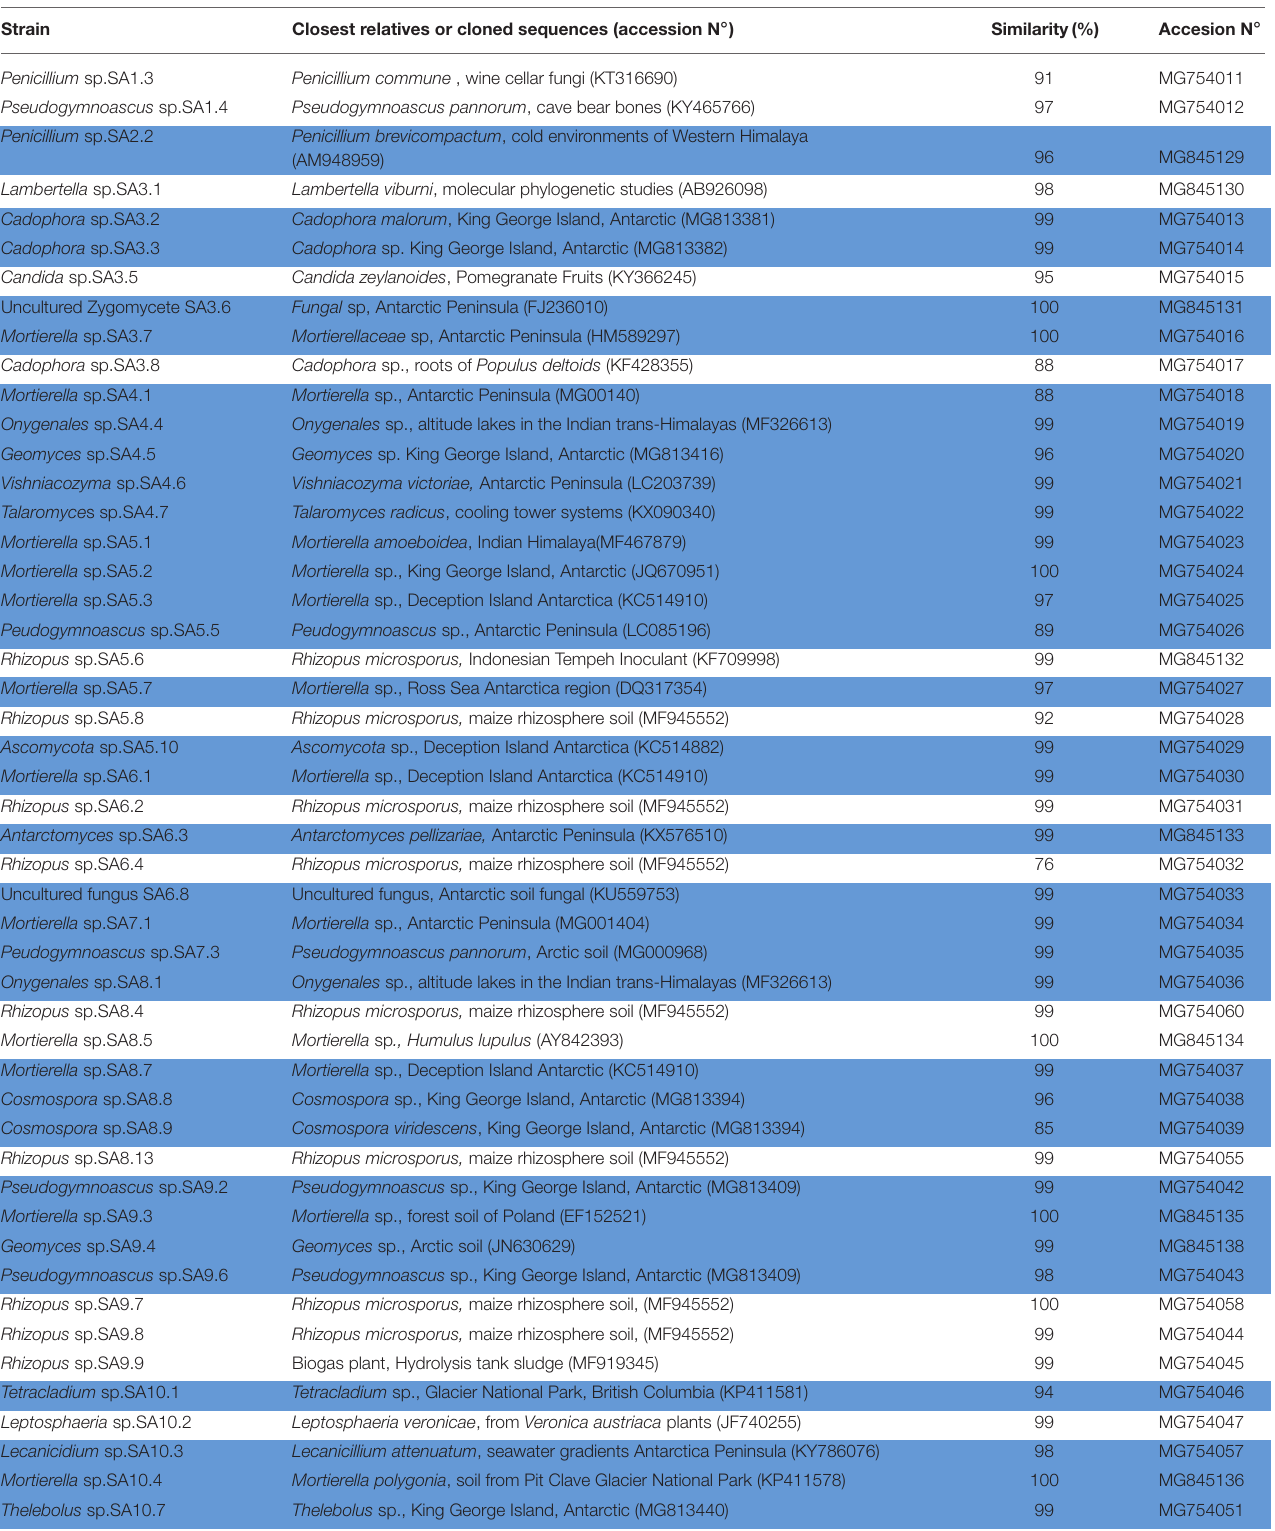
TABLE 2 | Fungal strains isolated from South Shetland